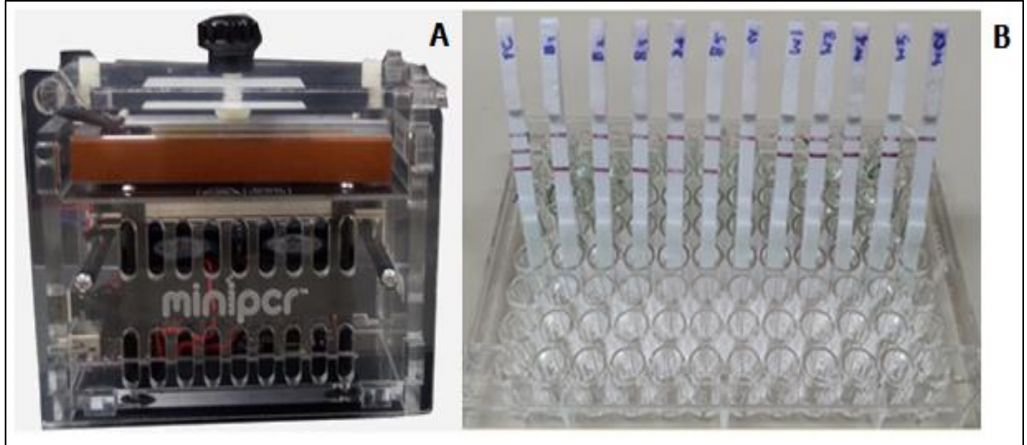
Figure 5. The miniPCR-DLFD for rapid detection and identification of microfilariae of lymphatic filariae in human blood samples. The miniPCR ( A ), and representative DLFD shows reaction of amplicon; strip 1: positive control containing W. bancrofti and B. malayi DNA, strips 2–11: representative of test samples, and strip 12: negative control ( B